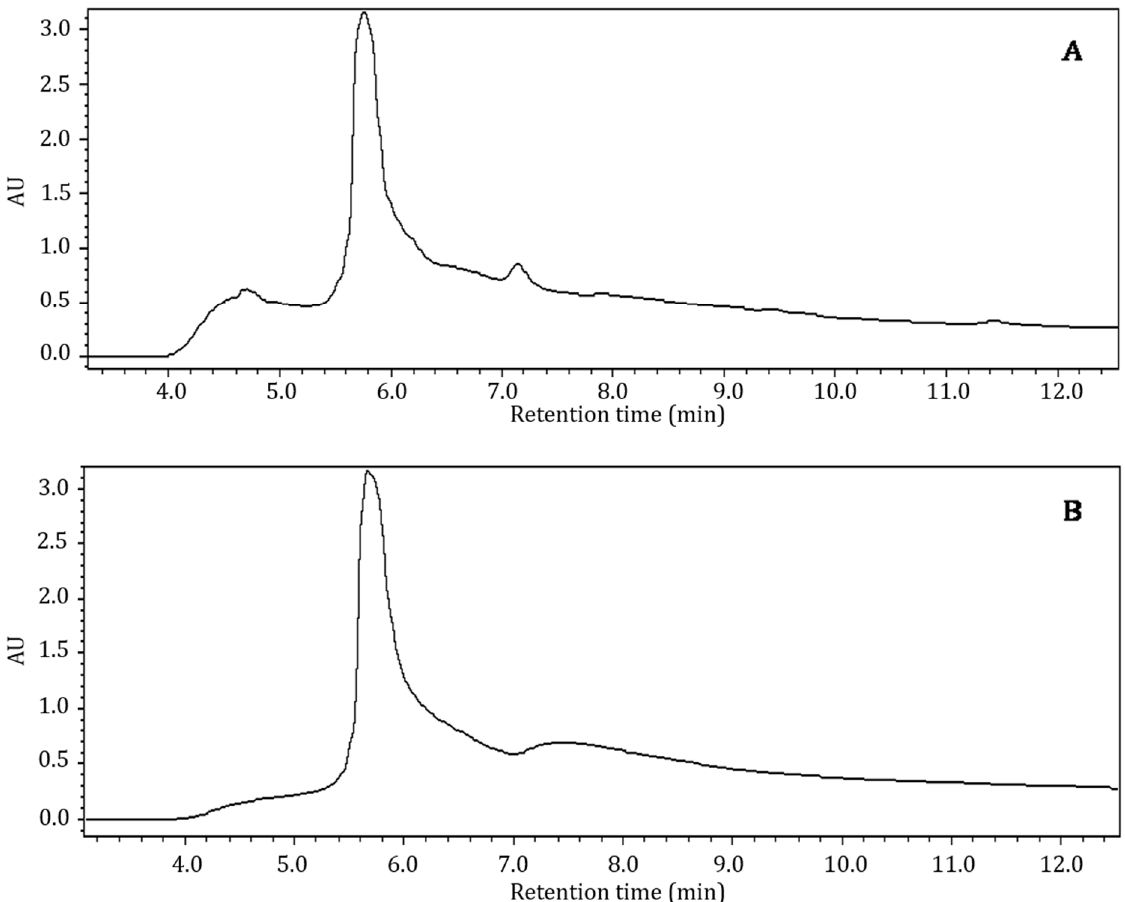
Figure 2. Bioactive profile of crude pecan shell Nacono extracts by reverse phase high performance liquid chromatography (RP-HPLC). Hyphenated chromatograms (3.5–12.2 min) by HPLC of crude pecan shell Nacono extracts. A 50 µL volume of methanol soluble components was injected into a c18 column, eluted with a binary mobile phase, and detected with a UV/VIS diode array absorbance detector. The chromatograms represent detection at the 280 nm wavelength channel. Pecan shells were subjected to solid-liquid extraction (20 g -L ) with distilled water at 98 °C for 1 h ( A ) or ethanol at 22 °C for 1 h ( B ) under constant mixing.